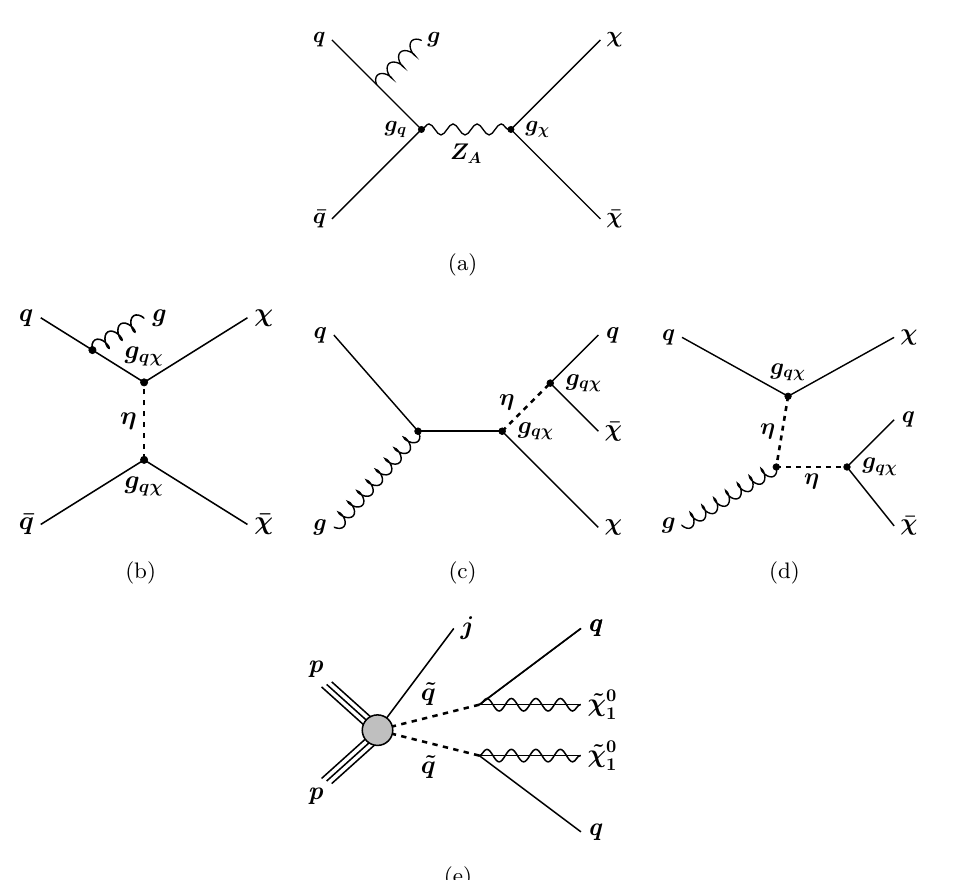
Figure 1 . (a) Diagram for the pair-production of weakly interacting massive particles (cid:31) , with a mediator Z A with axial-vector couplings exchanged in the s -channel. (b)(c)(d) Example of diagrams for the pair-production of weakly interacting massive particles (cid:31) via a coloured scalar mediator (cid:17) . (e) A generic diagram for the pair-production of squarks with the decay mode ~ q ! q + ~ (cid:31) 0 1 . The presence of a gluon from initial-state radiation resulting in a jet is indicated for illustration